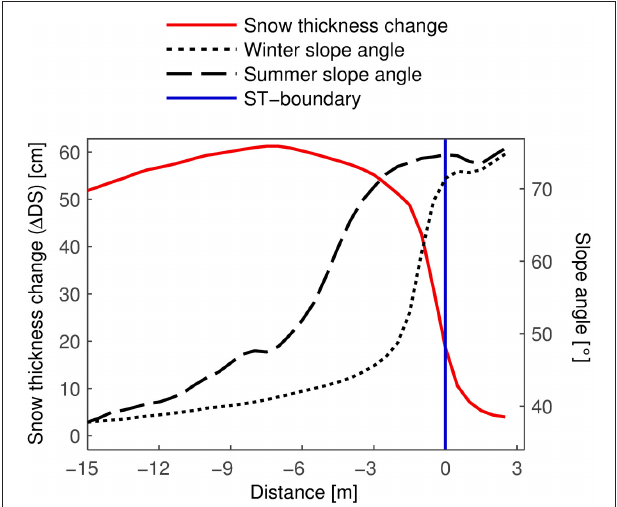
FIGURE 9 | Averaged transects of 1 DS (between 21 and 25 March) and winter and summer slope angle. The x -axis gives the distance from the ST-boundary. Negative values lie in the “slope toe.” 1 DS attained a maximum at –7 m and then decreased rapidly closer to the ST-boundary.